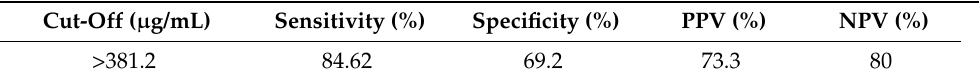
Table 2. Clinical performance characteristics of SAA1 levels at 72 h as a predictor of outcome. Sensitivity, specificity, PPV and NPV for the cut-off point selected are showed. PPV = Positive Predictive Value; NPV = Negative Predictive Value.